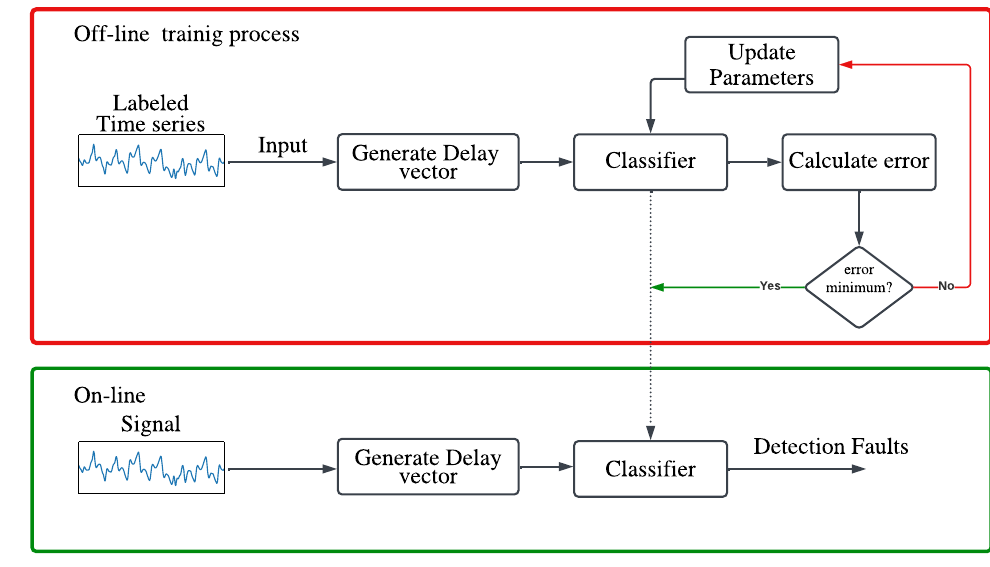
Figure 8. Flowchart of the offline and online processes.